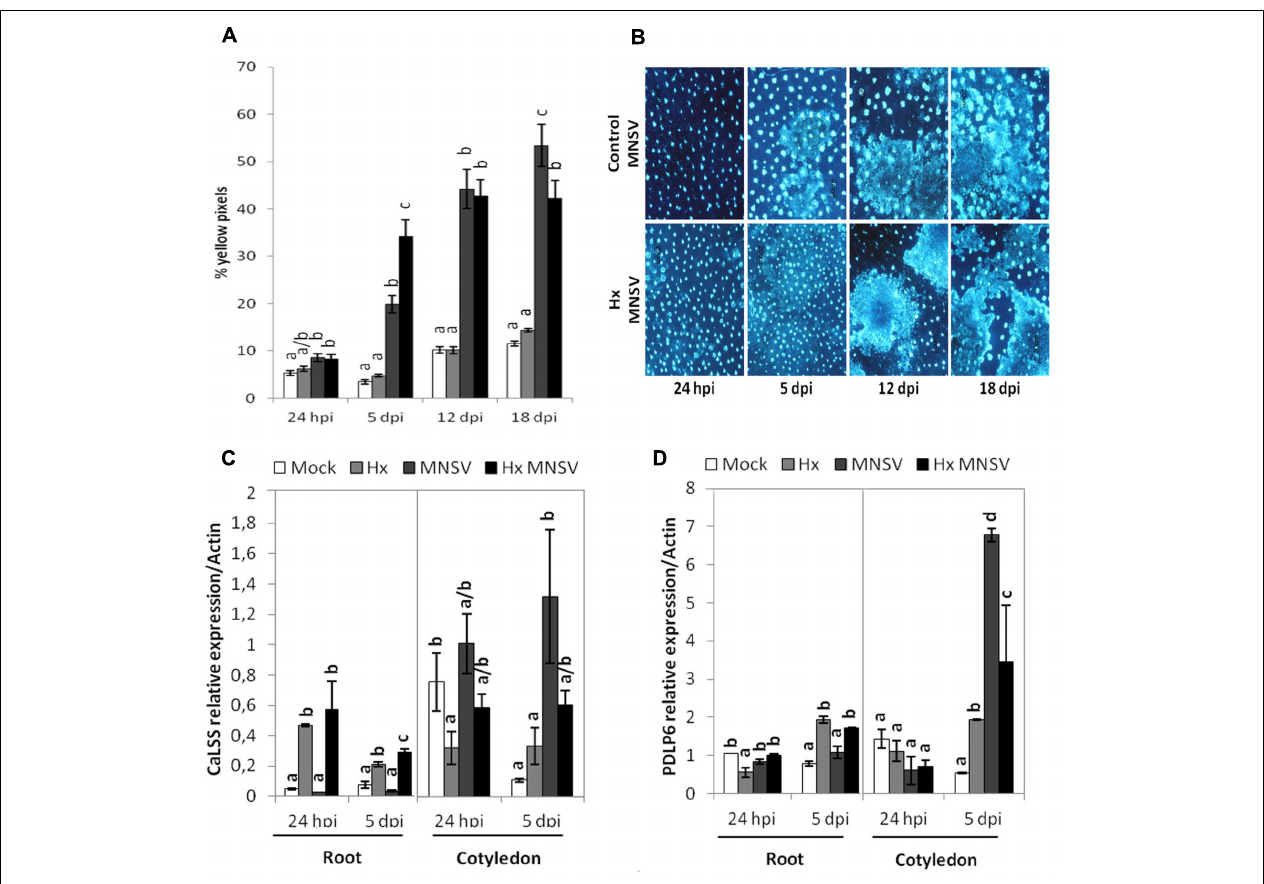
FIGURE 3 | Contribution of callose deposition to Hx-IR against MNSV. Plants were grown and inoculated as described in Figure 2C to determine the amount of callose deposition in the control and Hx-treated plants after MNSV infection. Melon cotyledons were sampled at 24 hpi and 5, 12, and 18 dpi, stained with aniline blue and analyzed by epifluorescent microscopy. (A) Quantification was performed by determining the percent of yellow pixels in relation to the total pixels in the photographs. Data represent the mean ± SE of three independent experiments with 10 plants per experiment. Letters indicate significant differences between treatments at each time point ( p < 0.05; least significant difference test). (B) Representative pictures of callose deposition in the control and the Hx-treated plants upon MNSV infection (Hx-MNSV). Total RNA was isolated from cotyledons and roots at 24 hpi and 5 dpi, and was converted into cDNA and subjected to a qRT-PCR analysis. The relative level of (C) CaLSS and (D) PDLP6 was analyzed in the control and treated plants. The results were normalized to the Actin gene expression measured in the same samples. Letters indicate significant differences between treatments at each time point ( P < 0.05; least-significant difference